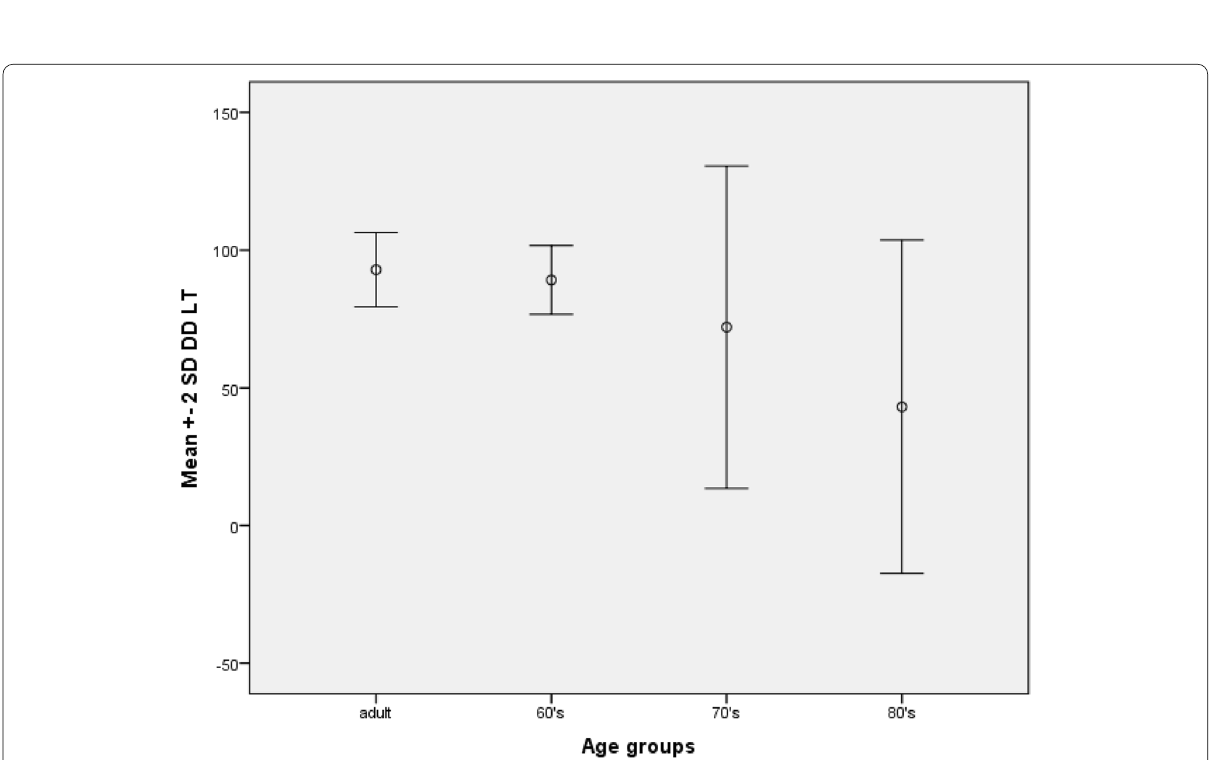
Fig. 2 Mean and SD of scores of DD test in the left ear in the adult group and elderly